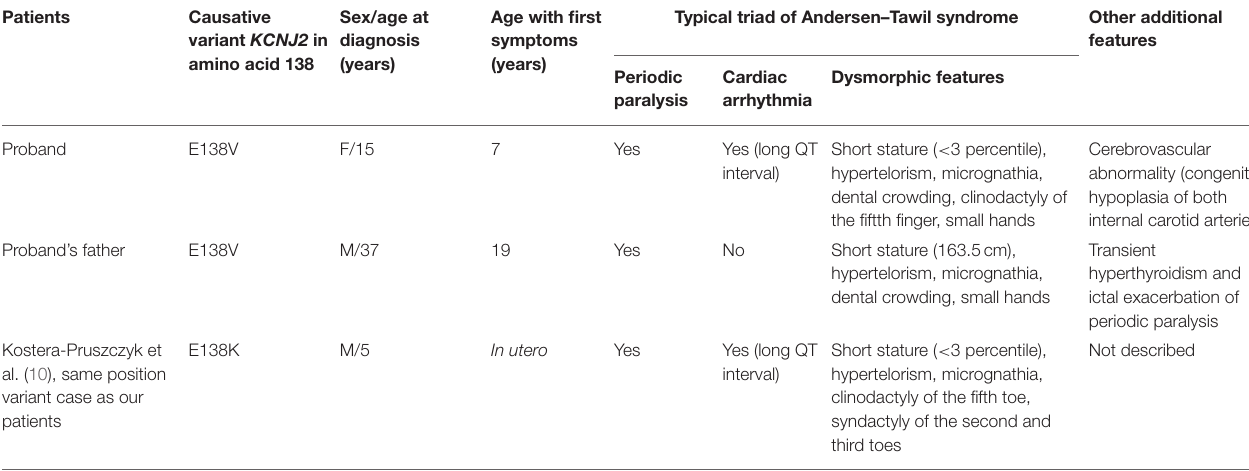
TABLE 1 | Clinical details of ATS patients with pathogenic/likely pathogenic variants in Kir2.1 at position